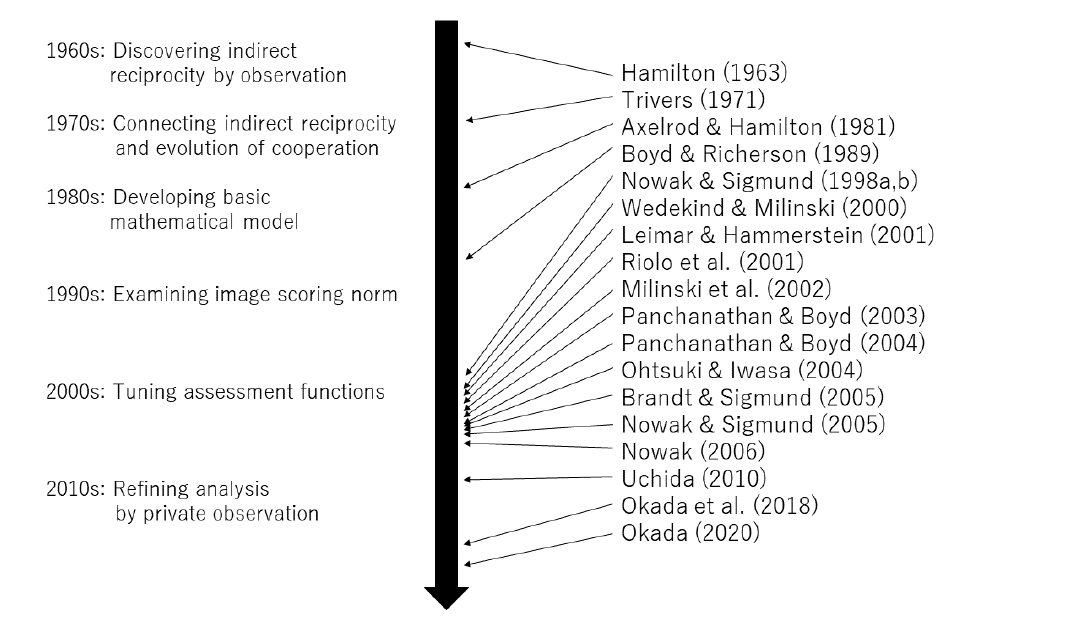
Figure 1. Historical overview of indirect reciprocity research and milestone